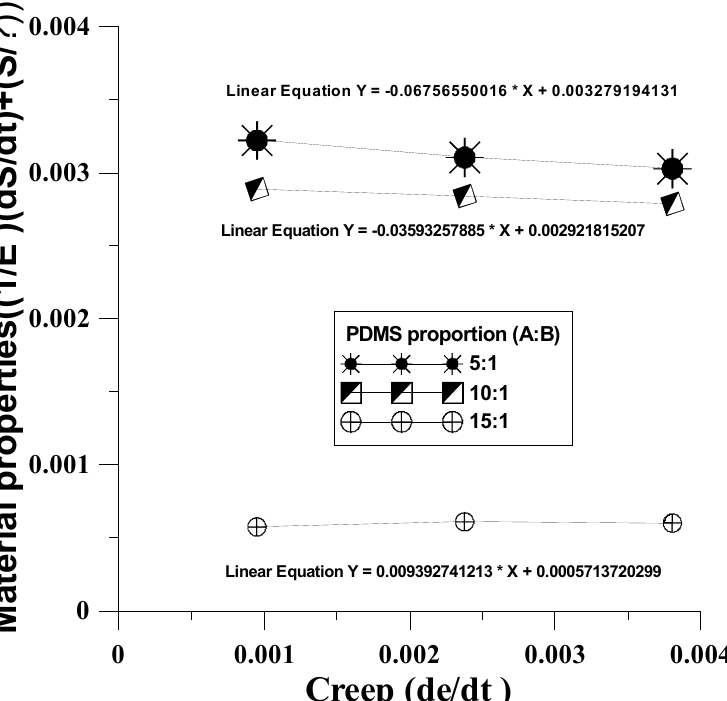
Figure 9. Time-dependent creep behavior of dependent variables in the dynamic tensile process of the Maxwell model.